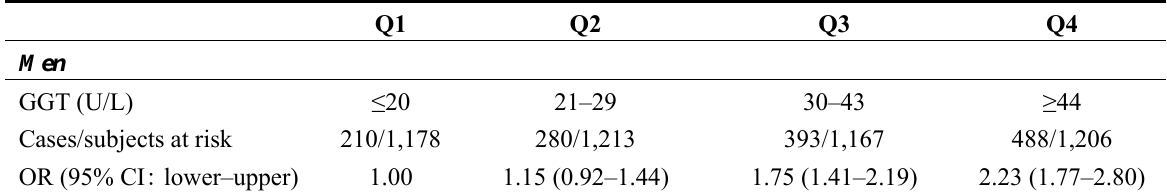
Table 7. Factors associated with elevated FPG by